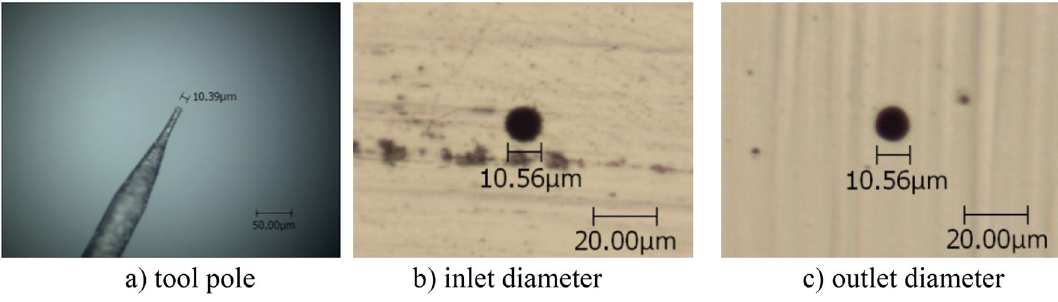
Figure 4. Micro hole produced at k 2 = 0.7 and k 1 = 0.2.